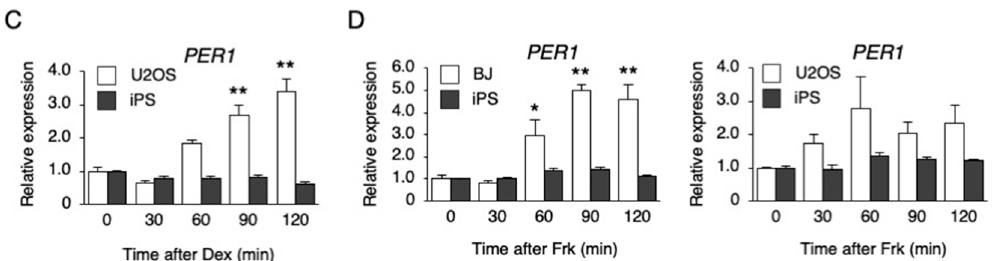
Figure 1. The response of clock genes to synchronizing stimulations in human-induced pluripotent stem cells (hiPSCs). ( A ) The expression levels of clock genes every 4 h after dexamethasone (Dex) stimulation in U2OS cells and hiPSCs. Data are presented as the means ± SEM relative to 0 h; n = 3 for each comparison. P values for the rhythmicity of DBP , PER2 , and BMAL1 were determined by a cosinor analysis as p = 0.08, p = 0.02, and p < 0.01 in U2OS cells, and p = 0.54, p = 0.03, and p = 0.11 in hiPSCs. ( B ) The expression levels of clock genes every 4 h after forskolin (Frk) stimulation in BJ cells and hiPSCs. Data are presented as the means ± SEM relative to 0 h; n = 3 for each comparison. p values for the rhythmicity of DBP , PER2 , and BMAL1 were determined by a cosinor analysis as p = 0.26, p = 0.29, and p = 0.02 in BJ cells, and p = 0.89, p = 0.21, and p = 0.59 in hiPSCs. ( C ) The expression level of PER1 after treatment with 0.1 µ M Dex in U2OS cells and hiPSCs. Data are presented as the means ± SEM relative to each 0 h. n = 3 for each comparison. ** p < 0.01 versus the corresponding control. ( D ) The expression level of PER1 after treatment with 10 µ M Frk in BJ, U2OS cells, and hiPSCs. Data are presented as the means ± SEM relative to each 0 h; n = 3 for each comparison. * p < 0.05, ** p < 0.01 versus the corresponding control.